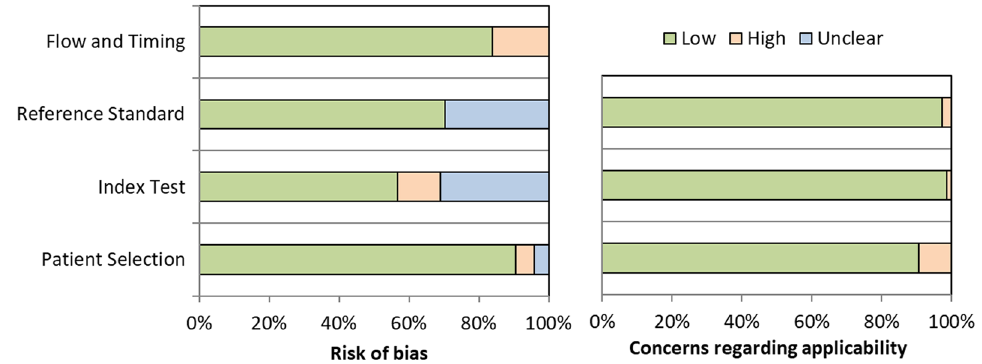
Fig. 2 Methodological quality of included